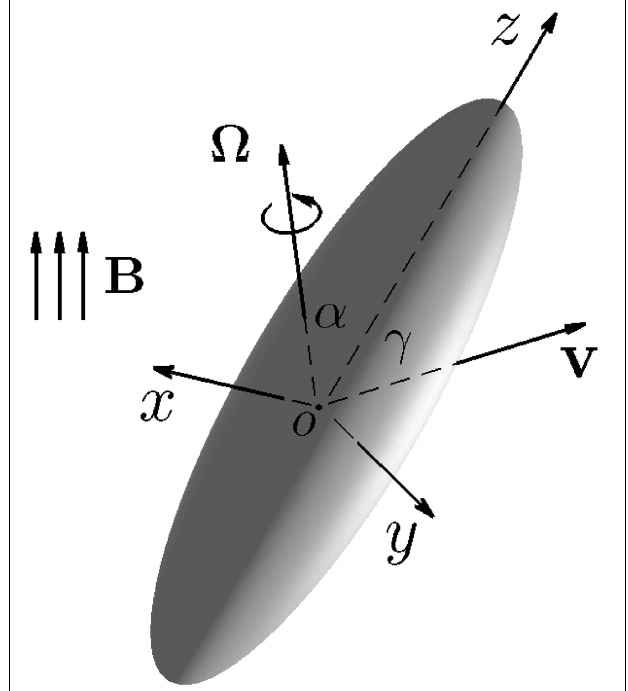
FIGURE 2 | Translation of a rod-shaped bacterium at an arbitrary angle of attack γ with the velocity v, where cartesian coordinates ( x, y, z ) are attached to the bacterium’s body. Rotation of a rod-shaped a rod-shaped bacterium with an arbitrary angle α and the angular velocity (cid:2) under the influence of an externally imposed, time-dependent magnetic field B